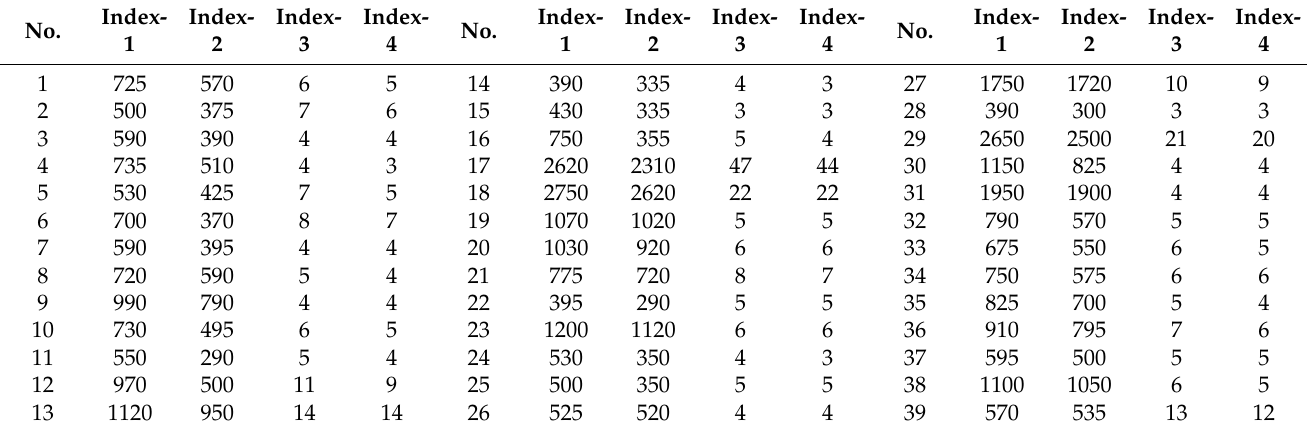
Table 1. Comparison chart of distance to evacuation and accessible